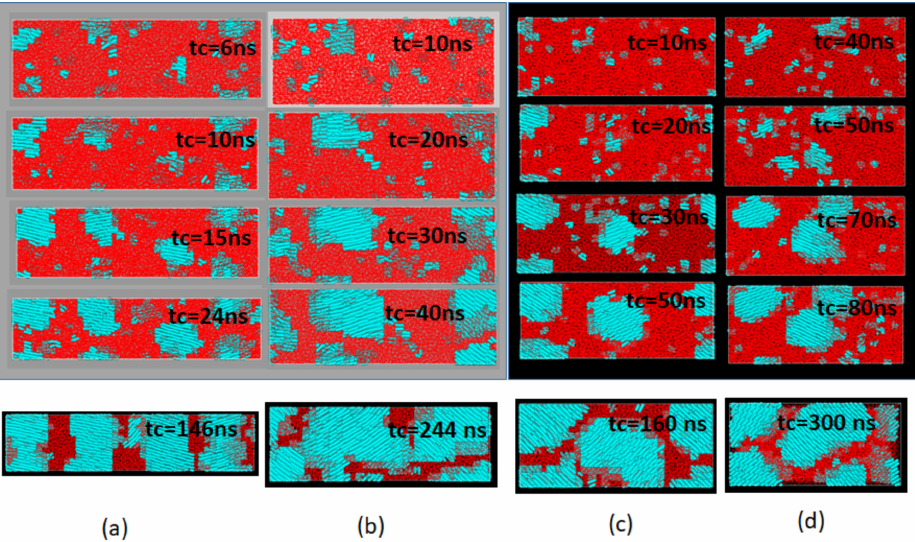
Figure 6. Typical morphological changes during the initial growth of the crystallites for different holing times t hold ; ( a ) t hold = 1 ns, ( b ) t hold = 2 ns, ( c ) t hold = 3 ns, and ( d ) t hold = 4 ns. In each snapshot are the times t c spent for the crystallization, while the last snapshot in each column indicates the final morphology obtained after a sufficient time of crystallization. The blue and red regions correspond to the crystalline and amorphous regions,